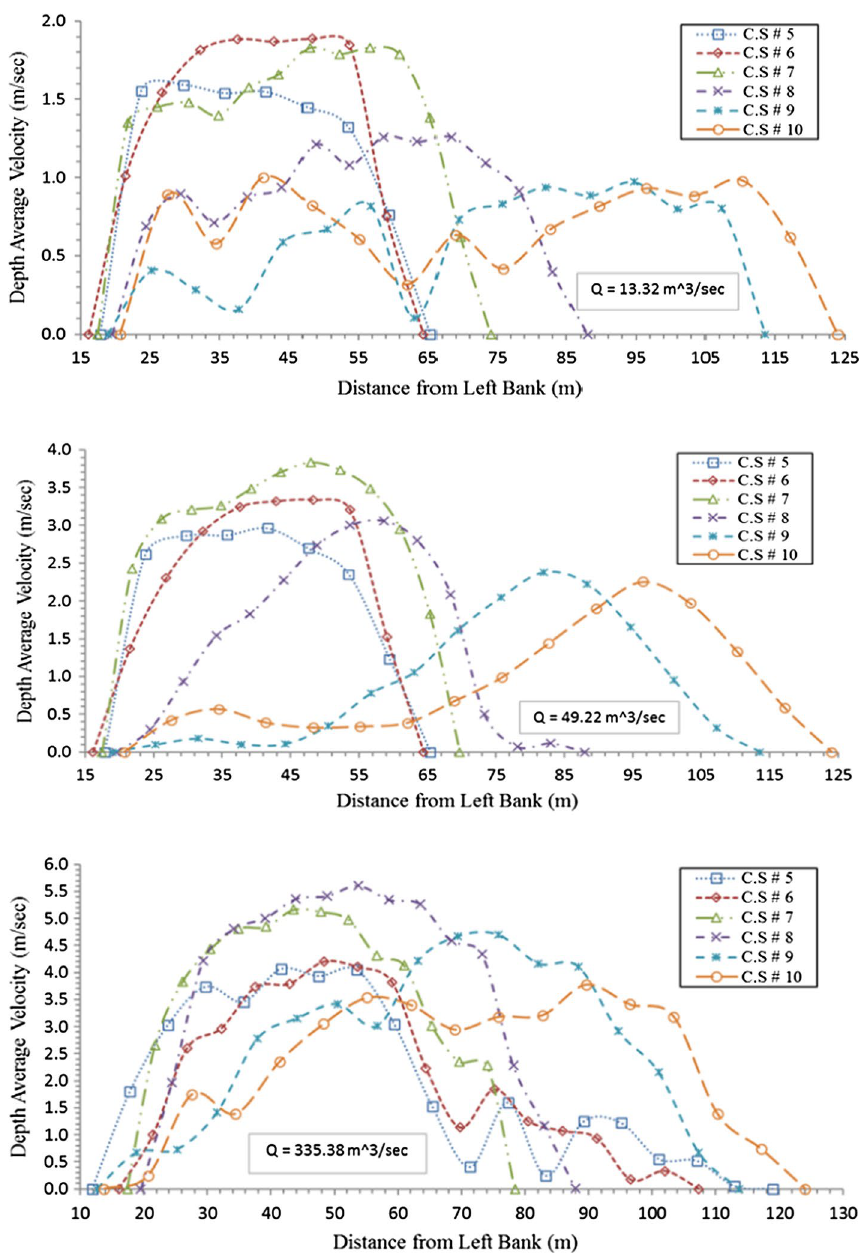
Fig. 12 Cross-profiles of depth average velocity in the meander